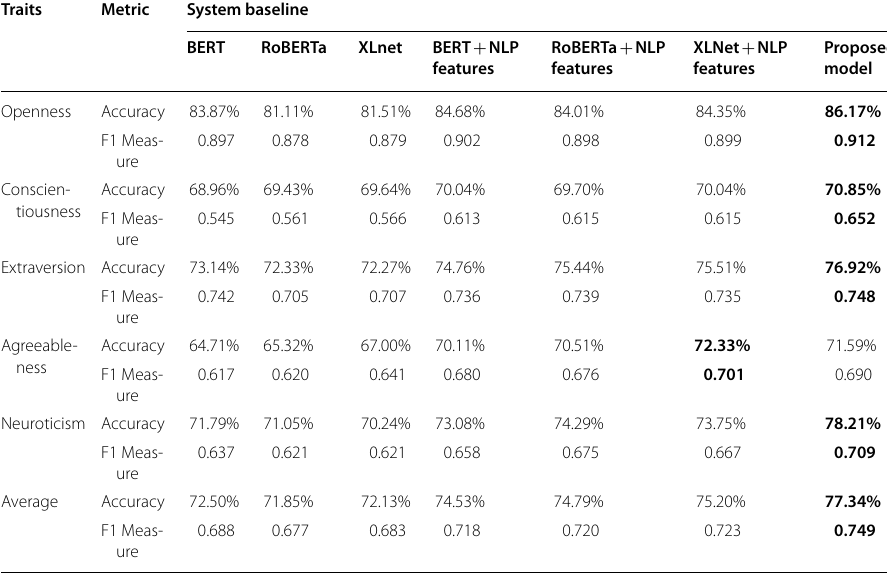
Table 7 Personality prediction result using Facebook